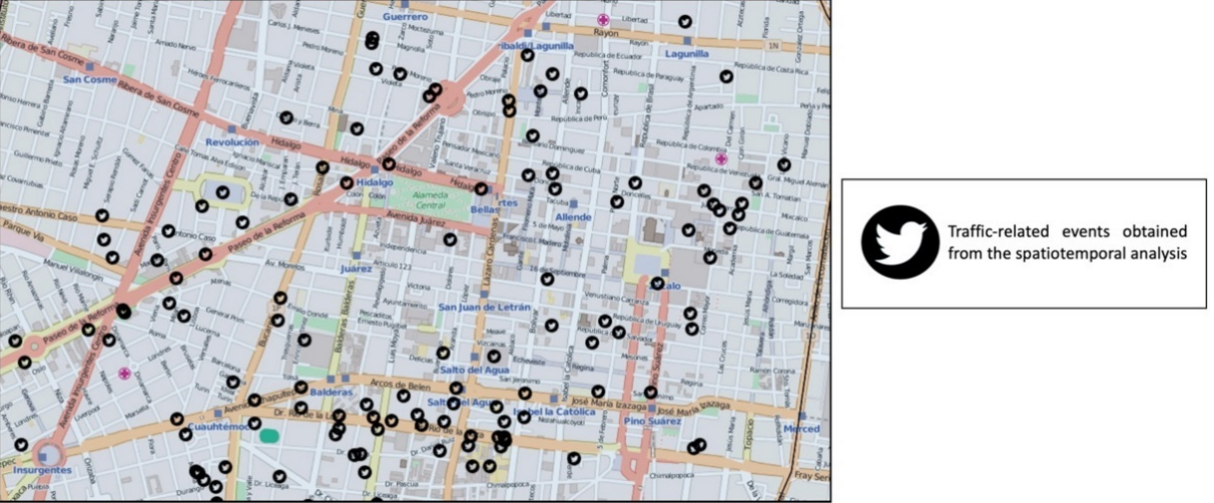
Figure 7. Traffic ‐ related events that were obtained from the spatiotemporal analysis. Figure 7. Traffic-related events that were obtained from the spatiotemporal